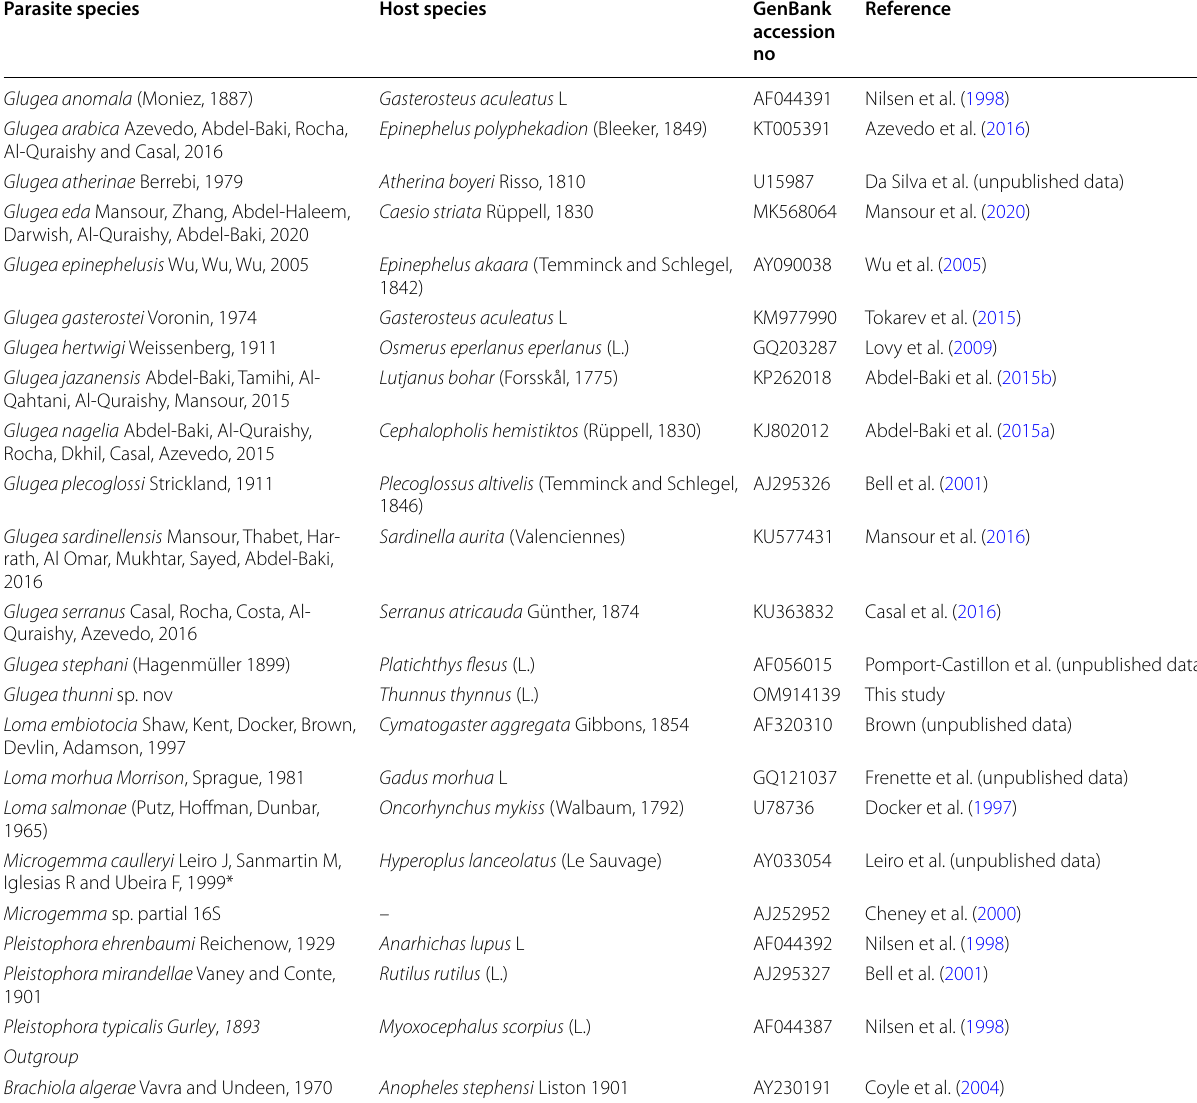
Table 1 Summary of the sequences of microsporidians used in the phylogenetic analyses retrieved from